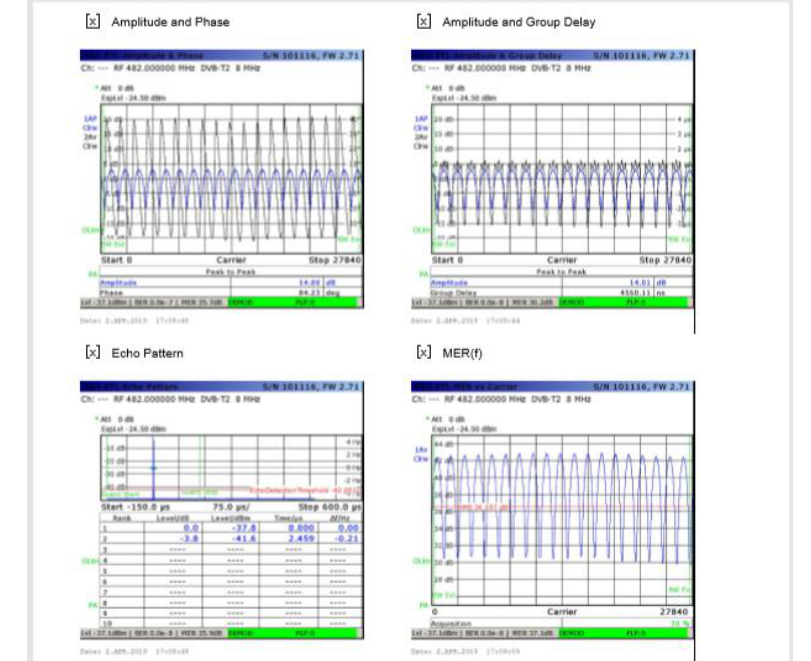
Figure 14. DVB-T2 Signal Form and Values parameters measured in the SFN mode: Level, -37.1 dBm; Δ Level, - 3.8 dB Δ Level, dB Amplitude 14.04 dB; Phase 85.29 deg; MER(f); MER (PLP, rms) 33.9 dB; Time offset 2 μs.